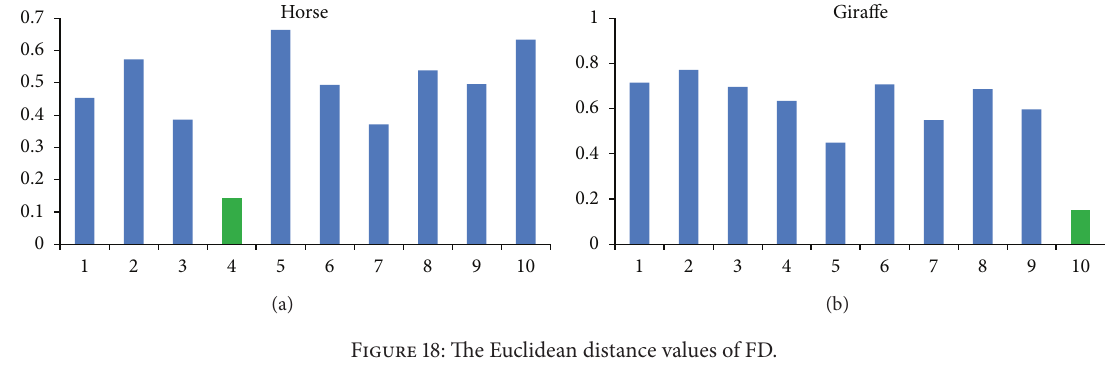
Figure 18: The Euclidean distance values of FD.